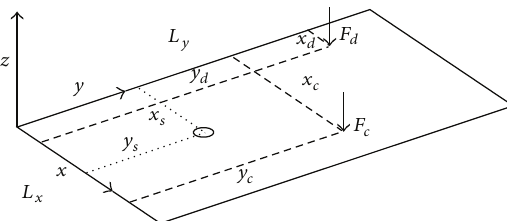
Figure 1: Coordinate system and force application on plate.